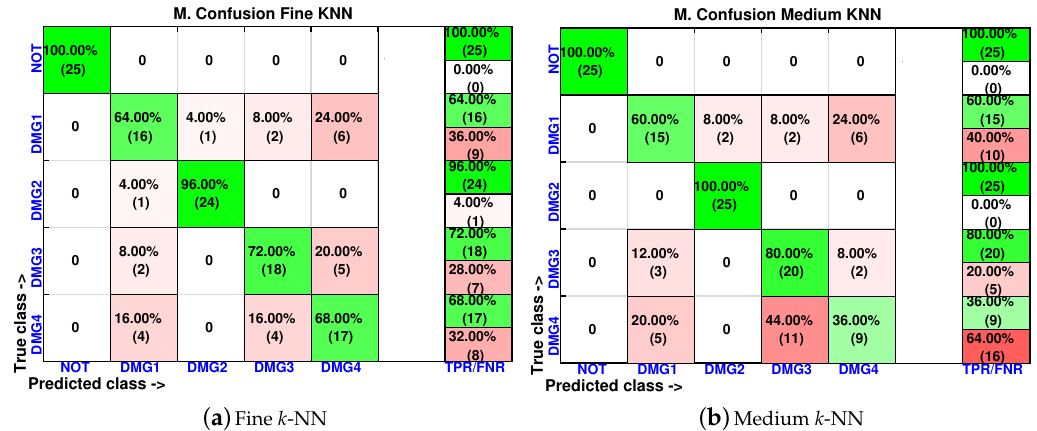
Figure 15. Confusion matrix using fine k -NN and medium k -NN when the feature vector is formed by the first principal component.